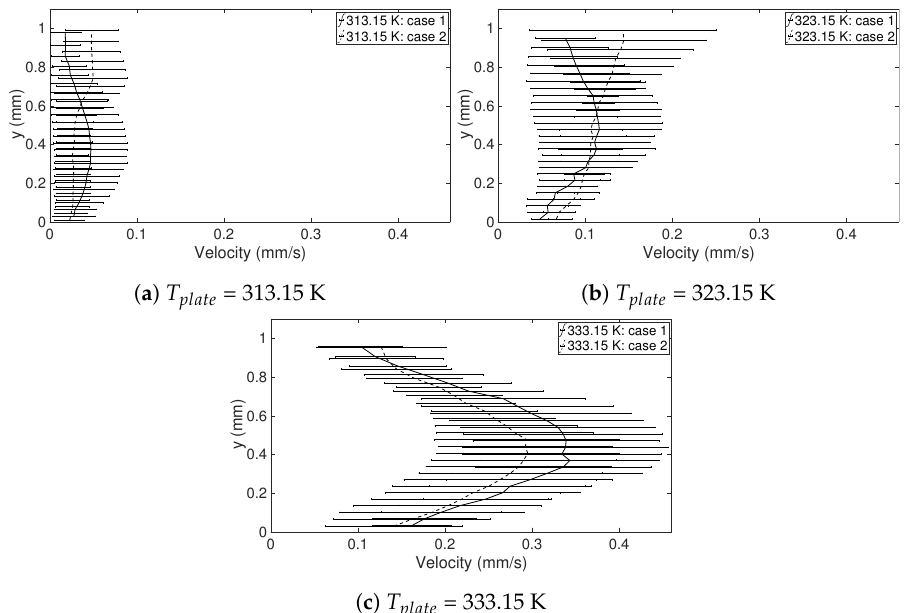
Figure 7. The spread (standard deviation) in velocity along the symmetry line during evaporation for T plate = 313.15, 323.15, and 333.15 K (all cases) when t = 1–15 s shown using error bars. The solid line is the mean velocity of all times.